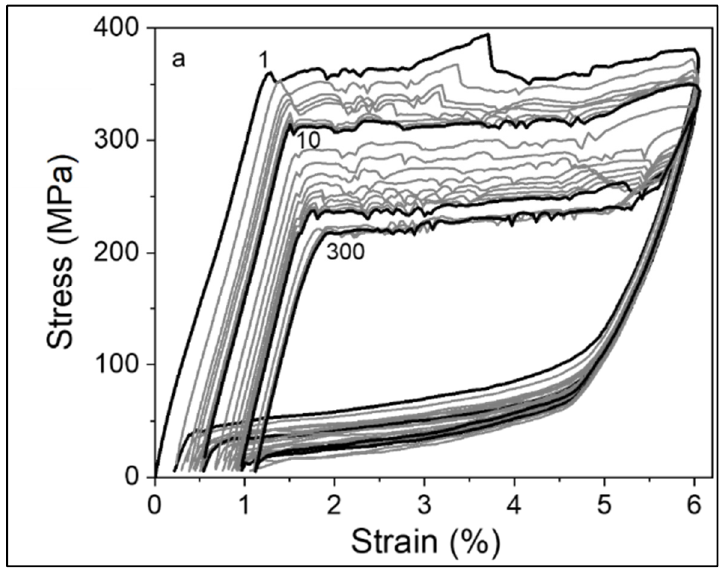
Figure 2. Stress-strain superelastic behavior up to 300th loading/unloading cycle of the NiTi (SMA wire) at room temperature.